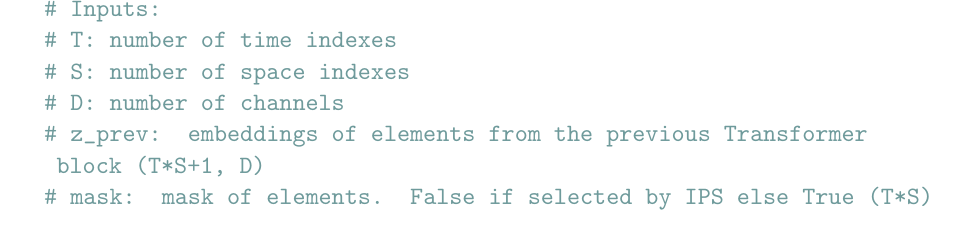
Algorithm 1: PyTorch-like pseudocode of a Transformer block with axis attention (spatial) and IPS. Lists of numbers in parentheses in comments indicate the shapes of